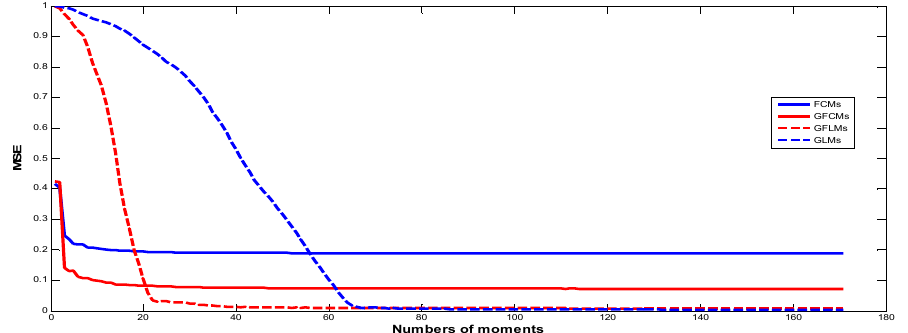
Figure 11. Shows the Mean Square Error MSE for the di ff erent proposed GFCMs, GLMs, and GFLMs compared with FCMs of the Lena image reconstruction error.